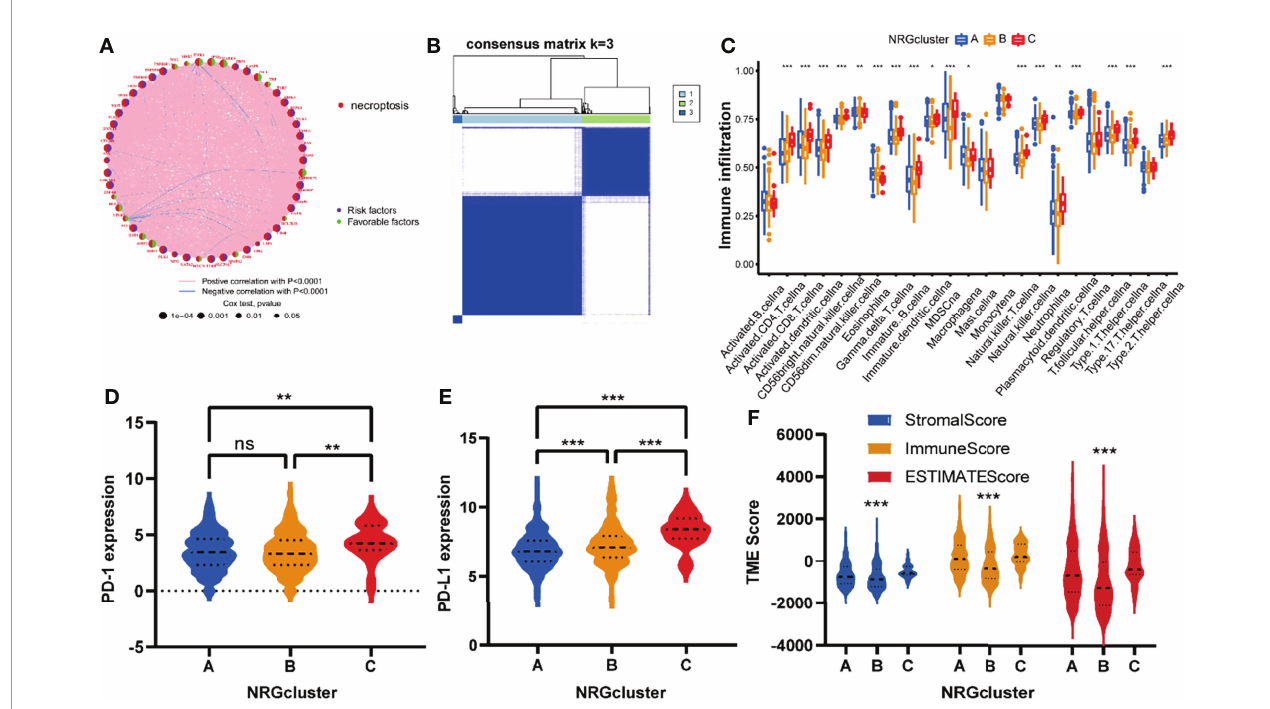
FIGURE 4 | NRGclusters of gliomas divided by consensus clustering algorithm and clinicopathological characteristics of distinct subtypes. (A) Interactions of NRGs in glioma. The thickness of the line that connects a pair of NRGs indicates the strength of their association. Positive correlations are indicated in red and negative correlations in blue. (B) Heatmap of the consensus clustering matrix (k = 3) dividing glioma patients into the three NRGclusters. (C) The comparison of in fi ltration levels of immune cells in three NRGclusters. (D, E) Expression of PD-1 and PD-L1 in three NRG clusters. (F) Correlation between three NRGclusters and TME scores. TME, tumor microenvironment; ***P<0.001, **P<0.01, *P<0.05, ns P >